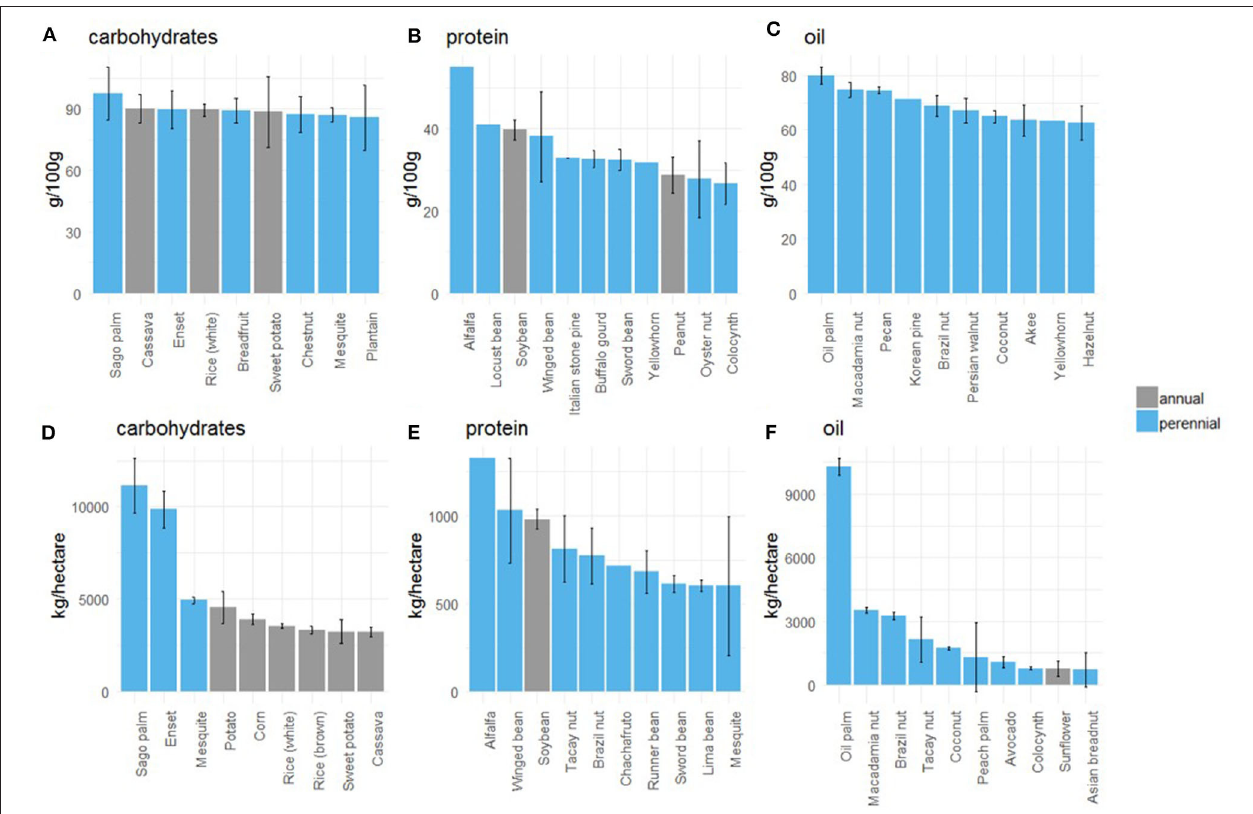
FIGURE 4 | Macronutrient content and yields of perennials relative to select annuals. (A–C) Show staple nutrient content (g/100g) for leading crops (those in the 85th percentile and higher for that nutrient). Nutrient content is based on the dry, edible portion of each crop. (D–F) Show estimated yields of each staple nutrient (kg/hectare) for leading crops (those in the 85th percentile and higher for each respective nutrient yield). If available, yields from the UN FAO were used; for crops without UN yield data, we used a mean yield estimate from our literature review. Error bars are 95% CIs based on distribution of nutrient data only; if absent, only one source of nutritional data was available for that nutrient of that